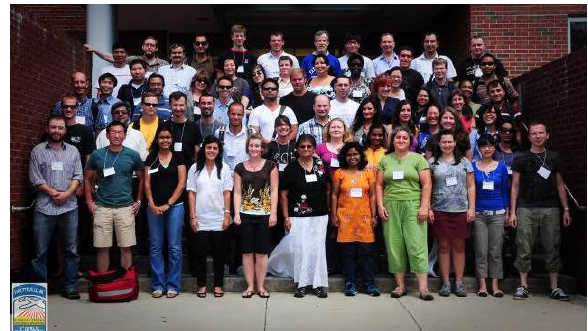
Figure 10. Group picture from Fayetteville Summer School.